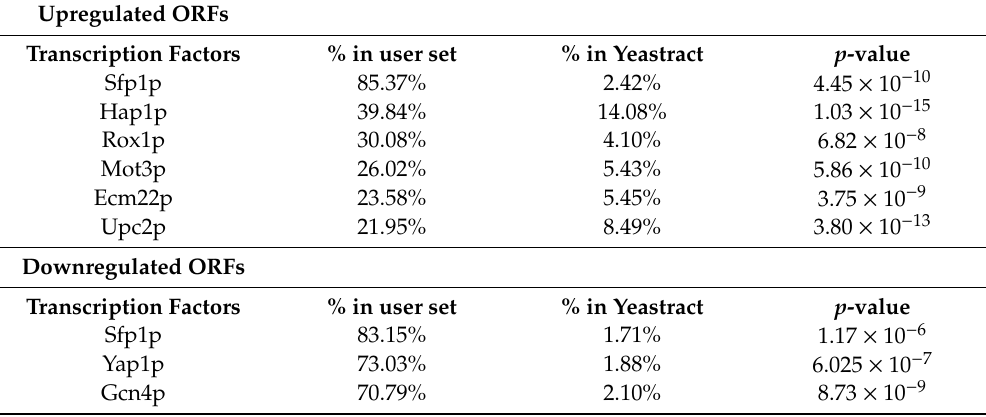
component of plasma membrane” are reported in Figures 4–6